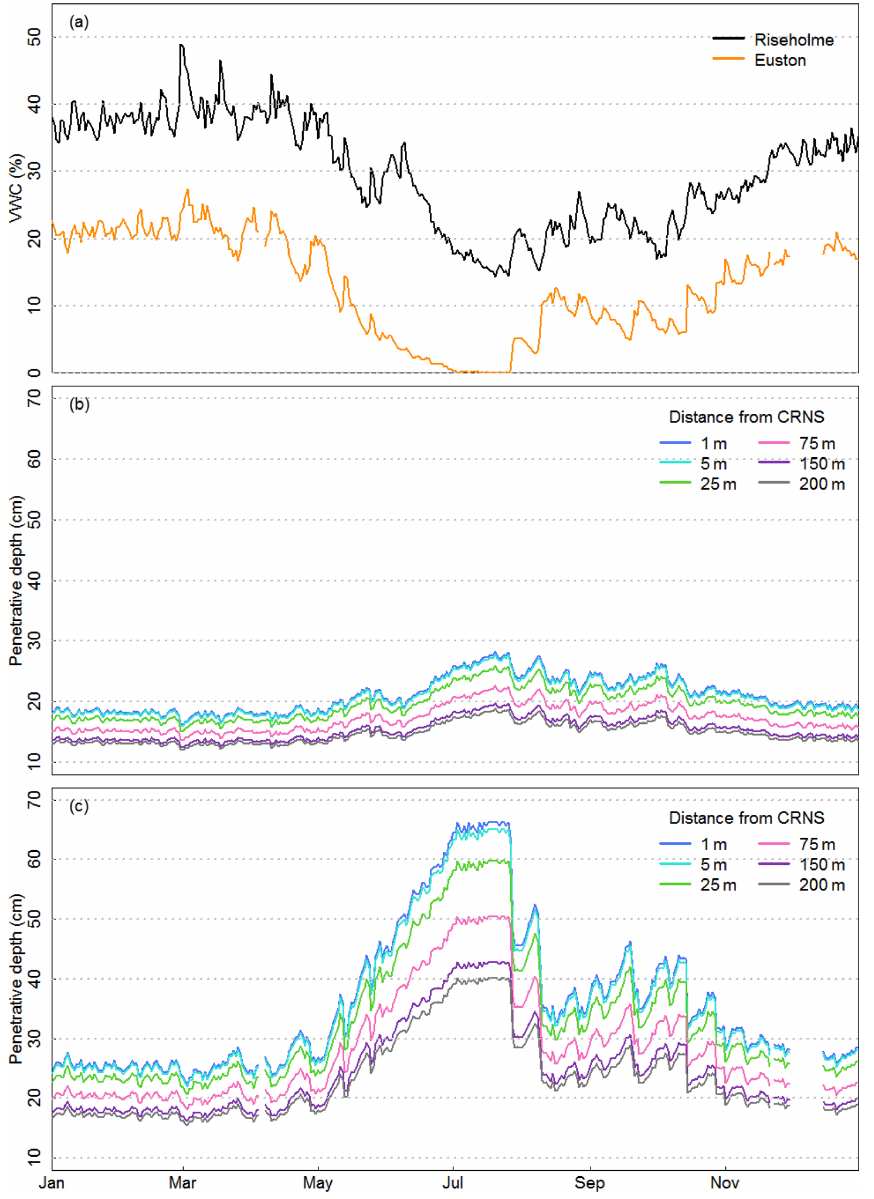
Figure 7. CRNS VWC and corresponding D86 penetrative depth estimates at a range of distances for two COSMOS-UK sites throughout 2018. (a) CRNS VWC for the Riseholme and Euston sites; (b) D86 values for Riseholme; (c) D86 values for